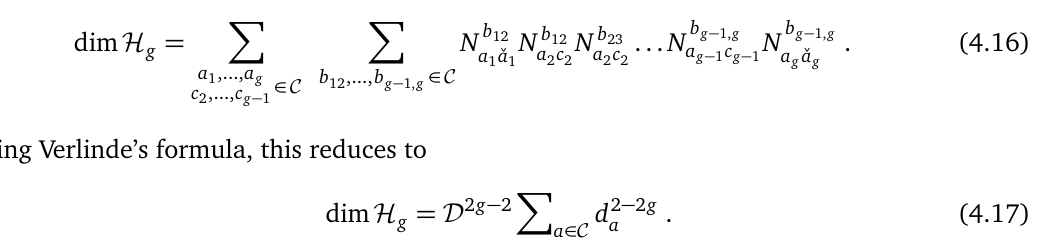
. Right: example of g